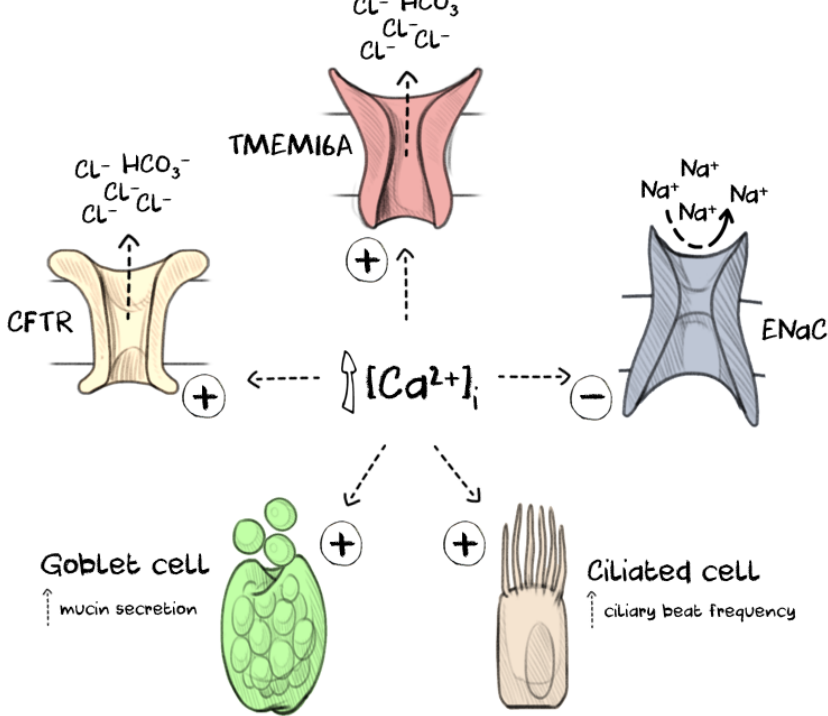
Figure 1. Increasing intracellular calcium levels [Ca 2+ ] i in the airway epithelium impacts several processes that regulate mucus clearance. Intracellular calcium signalling drives goblet cell exocytosis to release gel-forming mucins (commonly MUC5AC and MUC5B) onto the airway mucosa where they become rapidly hydrated and form a mucus gel. The fluid for hydration is provided by the coordinated activity of several ion channels, including cystic fibrosis transmembrane conductance regulator (CFTR), epithelial sodium channel (ENaC) and TMEM16A. Elevated intracellular calcium levels activate anion secretion through both TMEM16A and CFTR and attenuate sodium reabsorption by inducing internalisation of ENaC. The mucus gel is then cleared along the airways by the coordinated beating of cilia on the multiciliated cells, the frequency of which is also increased through calcium